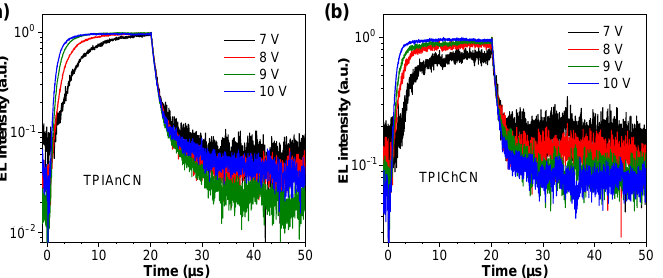
Figure 8. Transient EL decay profiles of the OLEDs at different applied voltages. ( a ) TPIAnCN and